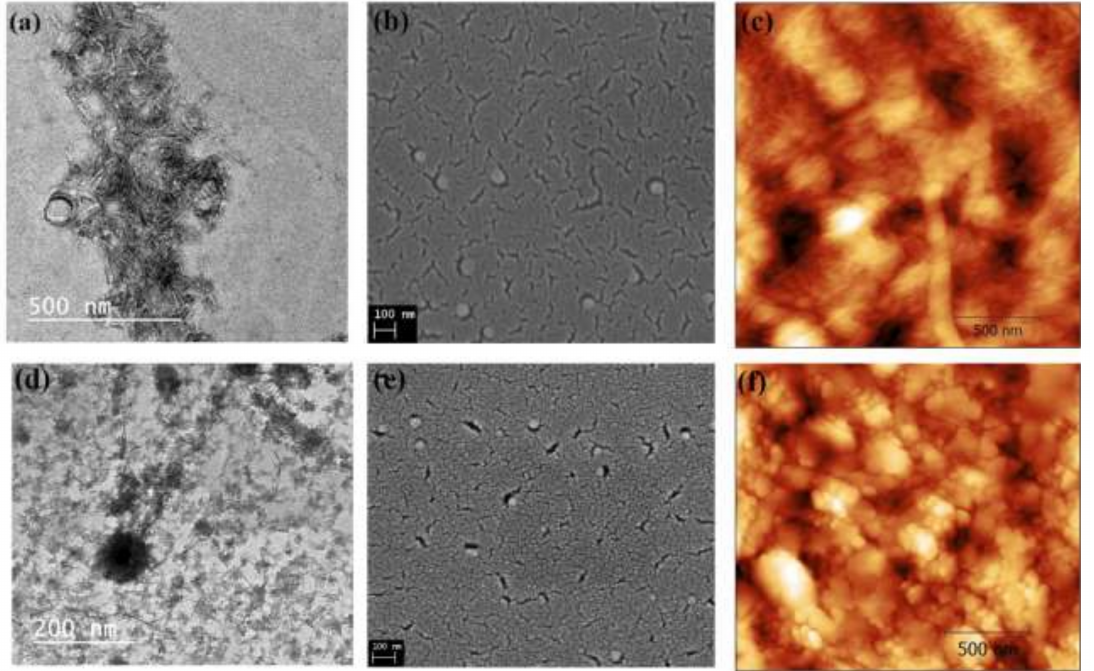
Figure 3. Morphological analysis for ONCs with ( a ) TEM, ( b ) SEM, and ( c ) AFM microscopy and for Ag–ONCs nanocom- posites with ( d ) TEM, ( e ) SEM, and ( f ) AFM microscopy,